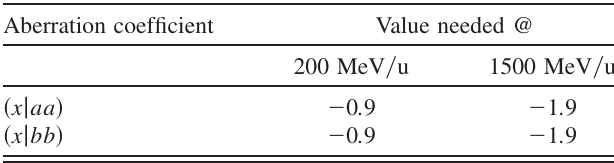
TABLE III. Some map elements that illustrate the scaling with rigidity of magnet settings. The numerical values are the coef- ficients required at the dispersive image for a 132 Sn beam incident on an aluminum degrader of thickness equal to 30% of the tin beam